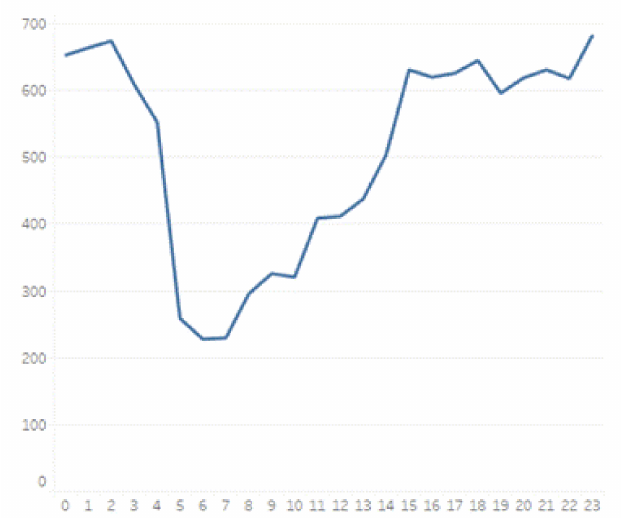
Figure 1. Time series plot of assaults in Manhattan, NY. The number of assaults increases from 7 a.m. to 11 p.m. (where 11 p.m. is the peak of assaults), and decreases during night hours from 1 a.m. to 6